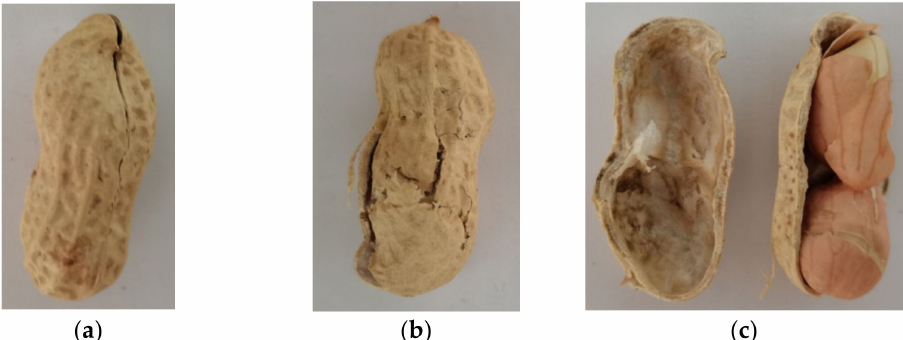
Figure 11. Pods with different degrees of crushing: ( a ) chapped pods; ( b ) crushed pods; ( c ) damaged pods.